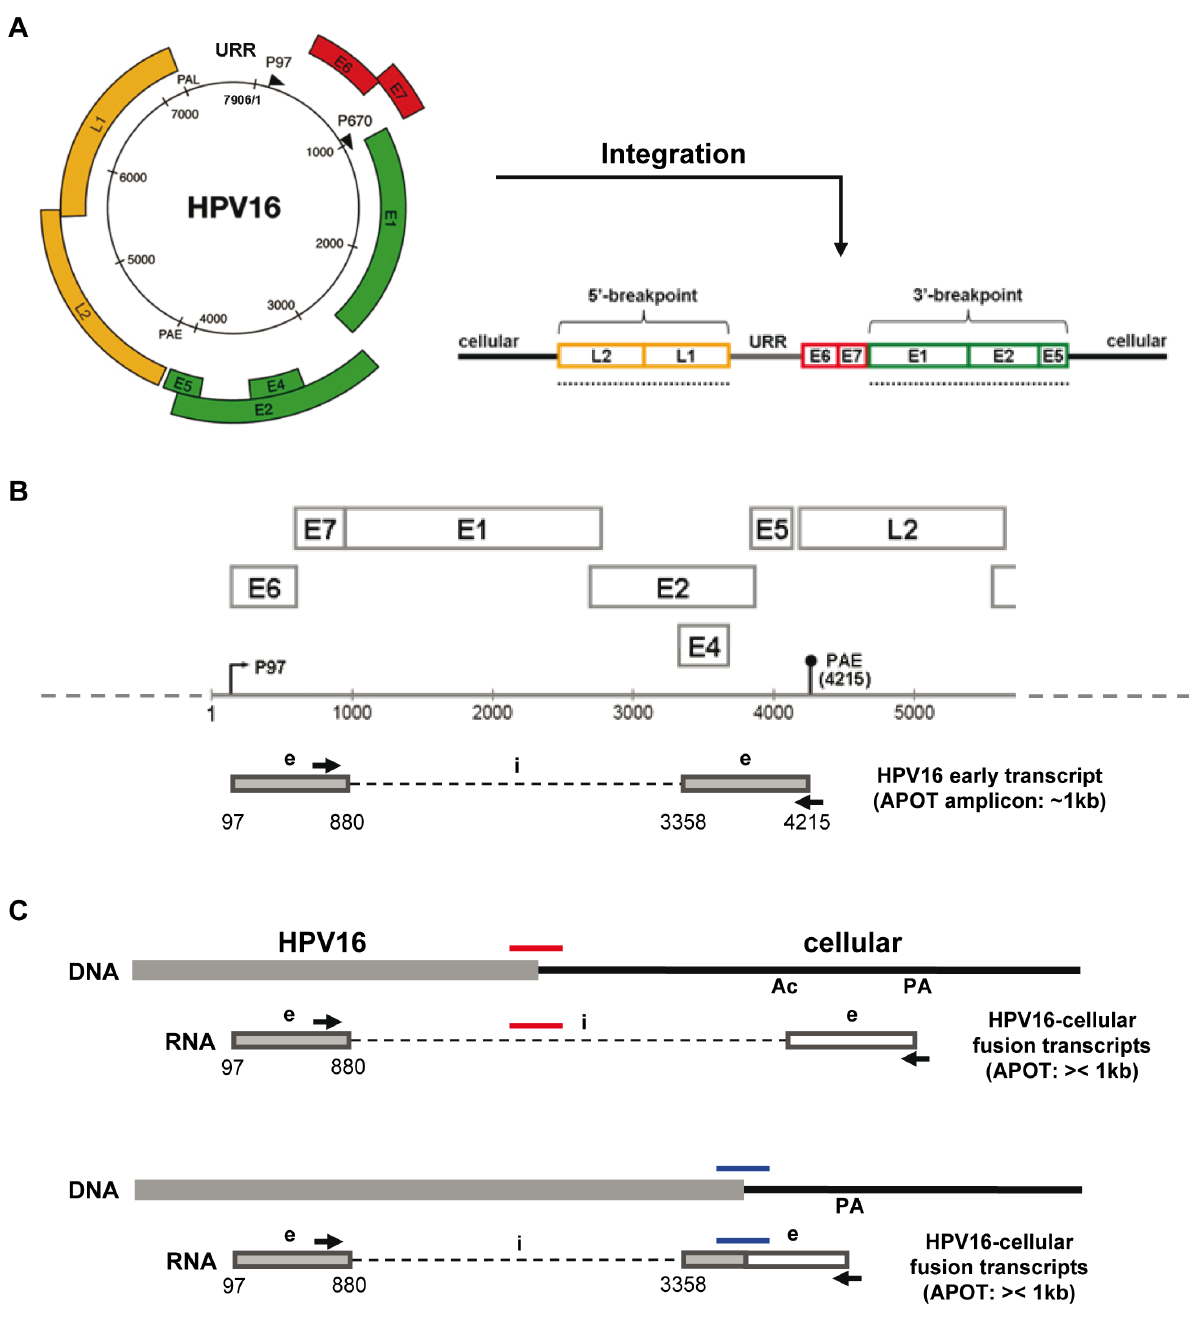
Figure 1. Genomic structure and transcription of episomal and integrated HPV16 DNA. (A) The circular HPV16 genome becomes linearized and inserted into the host cell genome upon integration. The breakpoints of integrated HPV16 DNA can be located anywhere in the L2-L1 region (5 9 breakpoint) and E1-E2-E5 region (3 9 breakpoint), respectively. The breakpoint regions are indicated by dotted underlines. The circular HPV16 genome is reproduced with slight modifications with permission, from Doorbar, (2006), (Clinical Science), (110), (525–541). (cid:2) the Biochemical Society. (B) In case of episomal HPV16 DNA, early transcription is initiated at the early promoter P97 and terminated at the early poly-A signal (PAE at pos. 4215). The early transcript shown contains two exons (e) with ORFs for E6, E7, E1ˆE4 and E5. An intron (i) of 2477 nucleotides is removed by splicing at the indicated donor and acceptor positions. Amplification of HPV16 oncogene transcripts by the APOT assay gives rise to a constant-size RT-PCR amplicon of , 1 kb [21]. The APOT primers are indicated by the arrows. (C) Early transcription from integrated HPV16 DNA will lead to HPV16- cellular fusion transcripts, because the viral PAE signal is missing and instead a cellular poly-A signal (PA) is adopted. If the 3 9 breakpoint is located upstream of the splice acceptor at position 3358, an alternative cellular splice acceptor (Ac) will be used, and the HPV16-cellular DNA junction sequence (red bar) will be spliced out as part of a viral-cellular intron (upper part). If the 3 9 breakpoint is located downstream of the splice acceptor 3358, the HPV16-cellular DNA junction sequence (blue bar) will remain as part of a viral-cellular exon, and the DNA and RNA junction sequences are colinear (lower part). The HPV16-cellular fusion transcripts are amplified in APOT assays as RT-PCR products that are shorter or longer than the , 1-kb amplicon derived from episomal HPV16 [21].